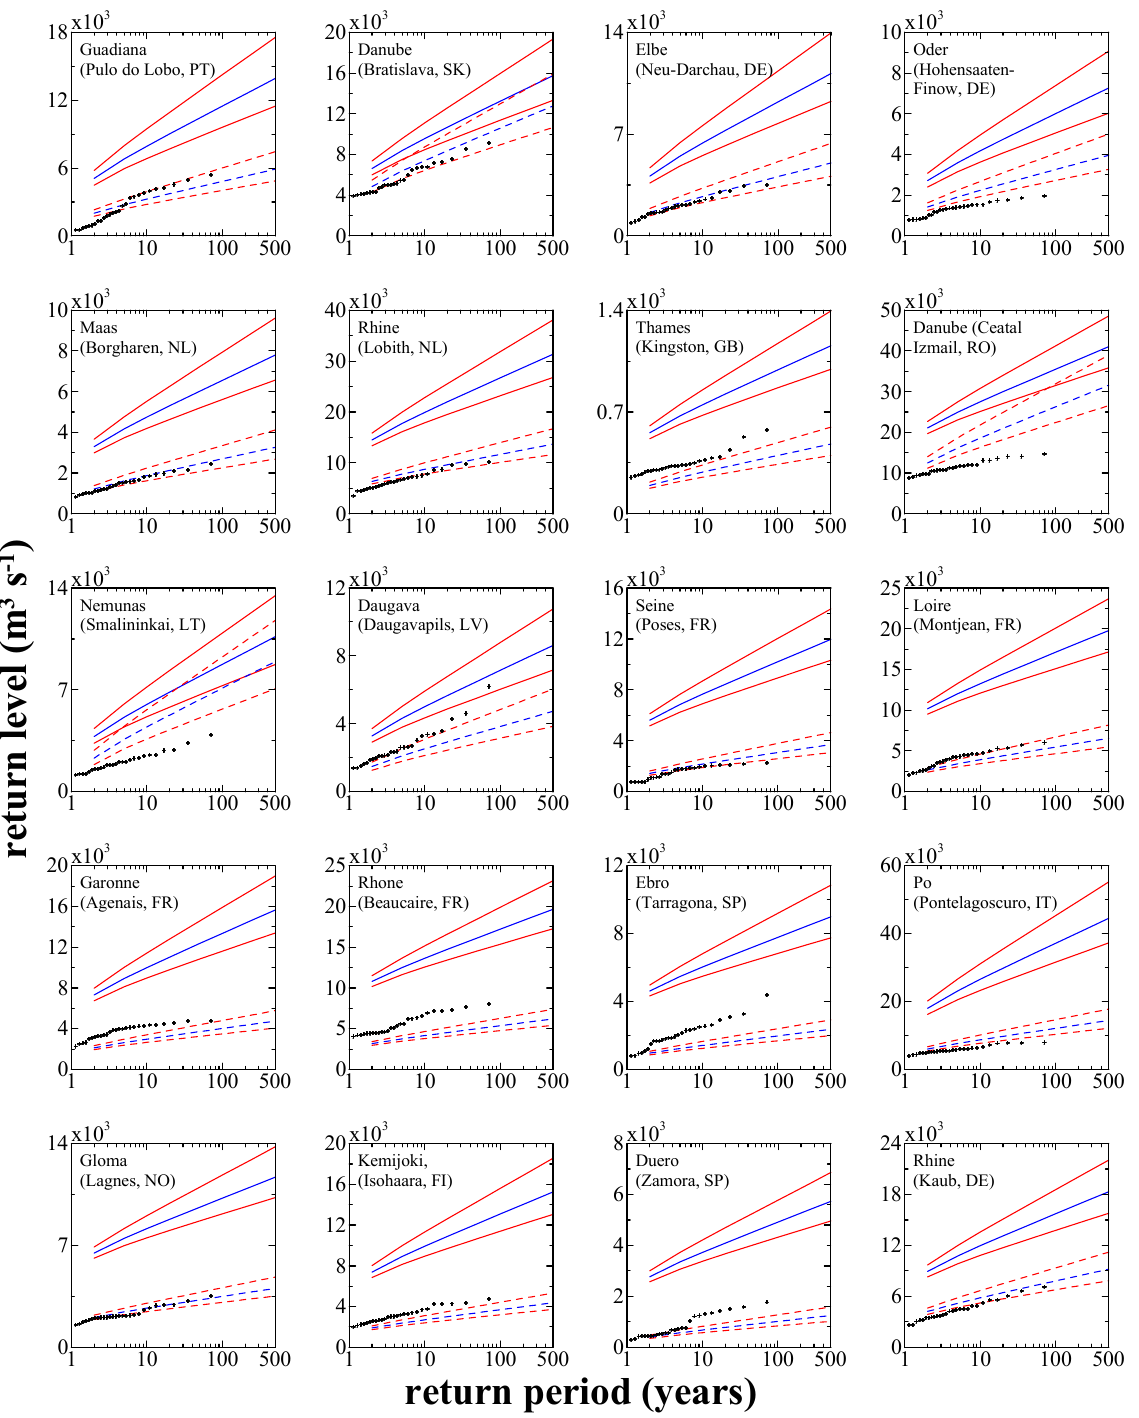
Fig. 11. Return level plots of simulated discharge levels in the 20 selected gauging stations showed in Fig. 1, based on a Gumbel distribution fit to the annual maxima for the control period 1961–1990. Full lines represent hydrological simulations driven by uncorrected forcing data whereas dashed lines represent the bias corrected counterpart. Also included in the plates are the 95% confidence intervals (red dashed- and full-lines) derived using the profile-likelihood method. Black crosses represent return levels obtained from empirical plotting positions of observed annual maximum discharges at the selected stations.